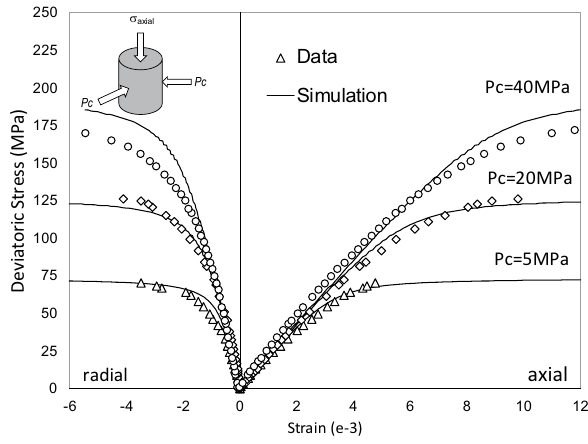
Fig. 8 Comparison of numerical simulations and experimental data of triaxial compression tests with confining pressures of 5, 20, and 40 MPa (Vosges sandstone)